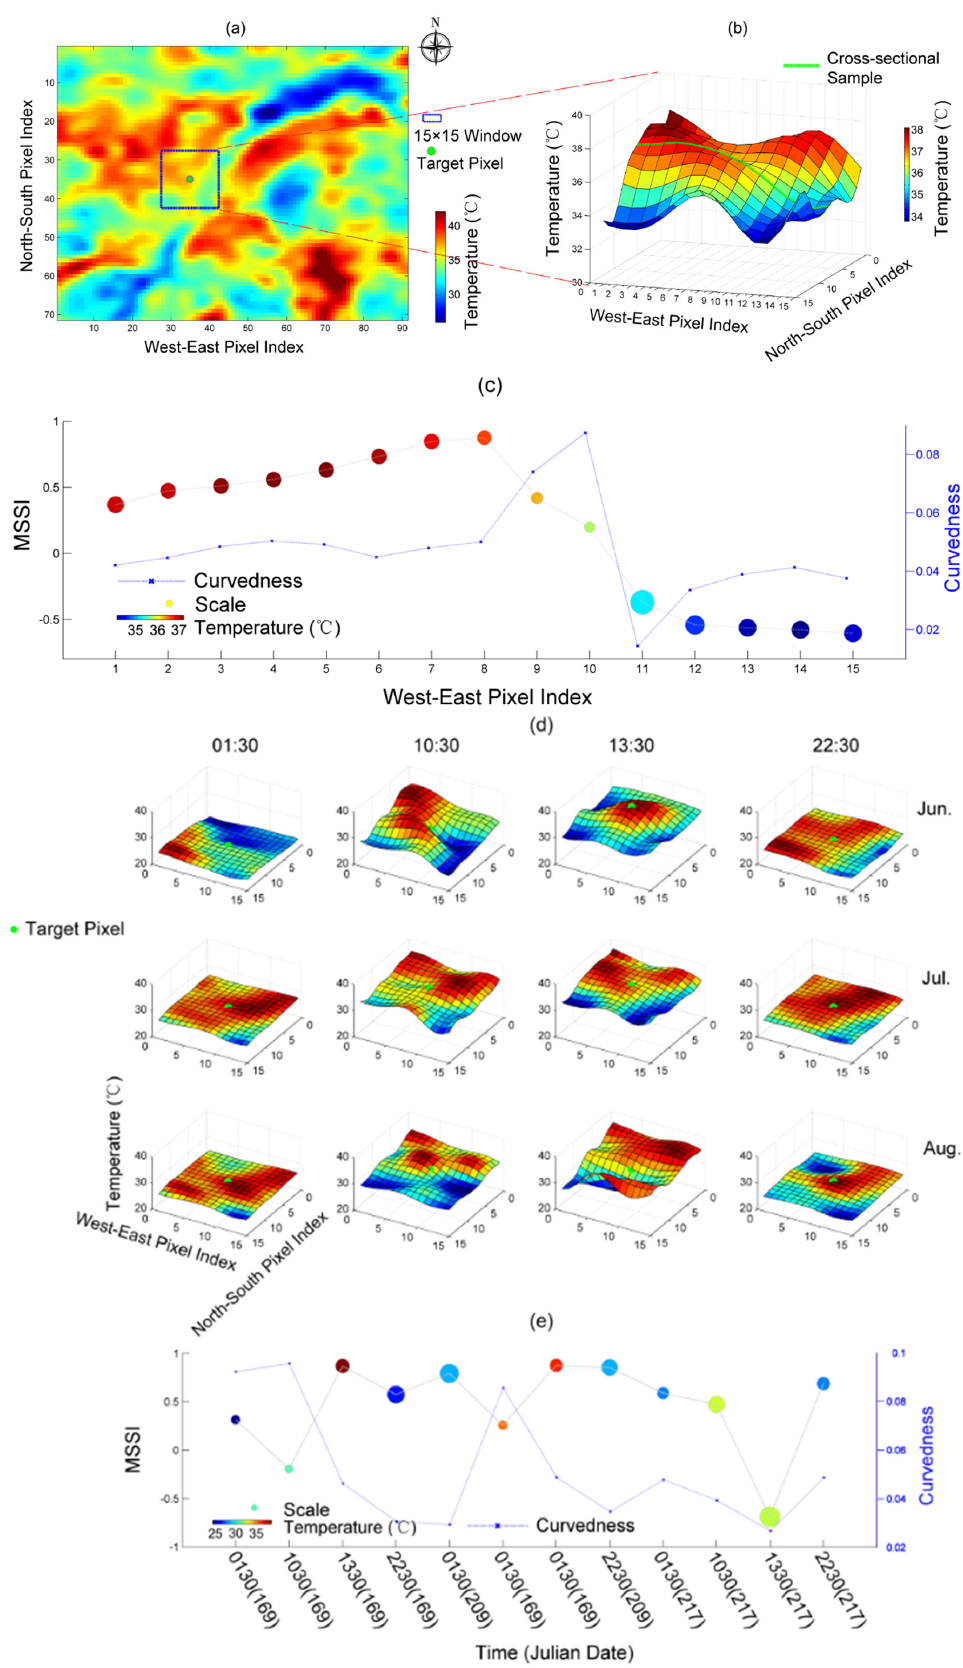
Figure 7. Spatial and temporal dynamics of sample LST. ( a ) The sample target of image at 13:30 July with its 15 × 15 neighbors; ( b ) The one-dimensional cross-sectional selection through the target; ( c ) The spatial dynamics of the cross-sectional sample; ( d ) The temporal temperature variation of the target relative to its neighbors through June, July and August; ( e ) The temporal dynamics of the target.